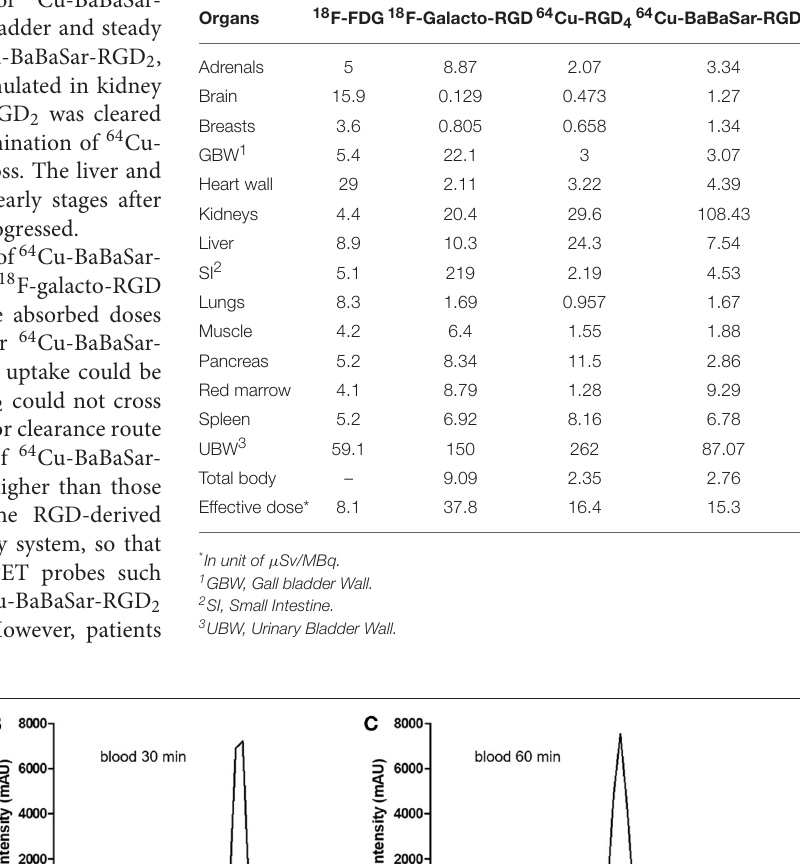
TABLE 4 | Organ doses in µ Gy/MBq for several pet imaging agents.